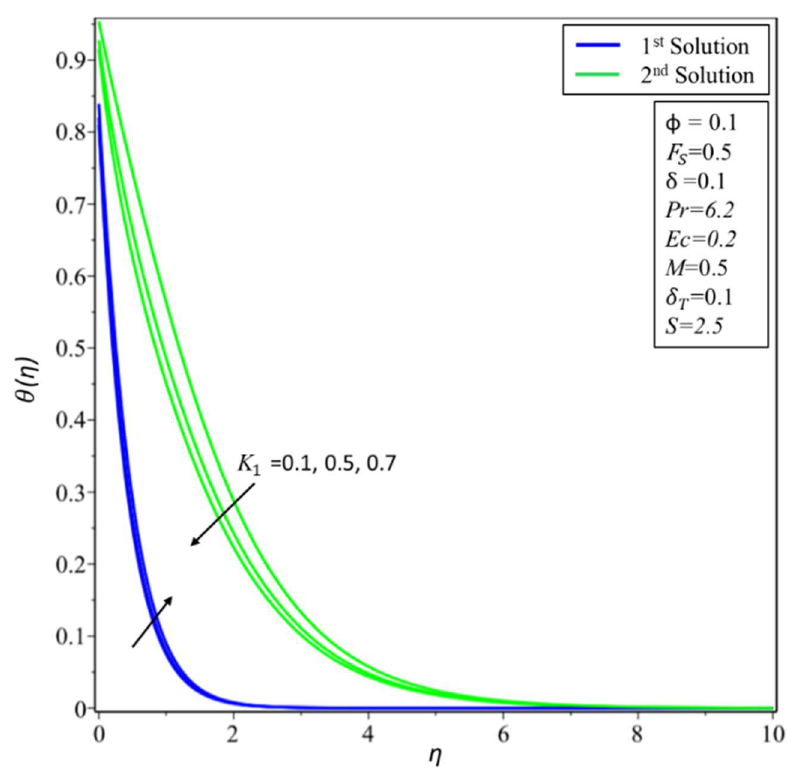
Figure 7. Changes of θ ( η ) for K 1.